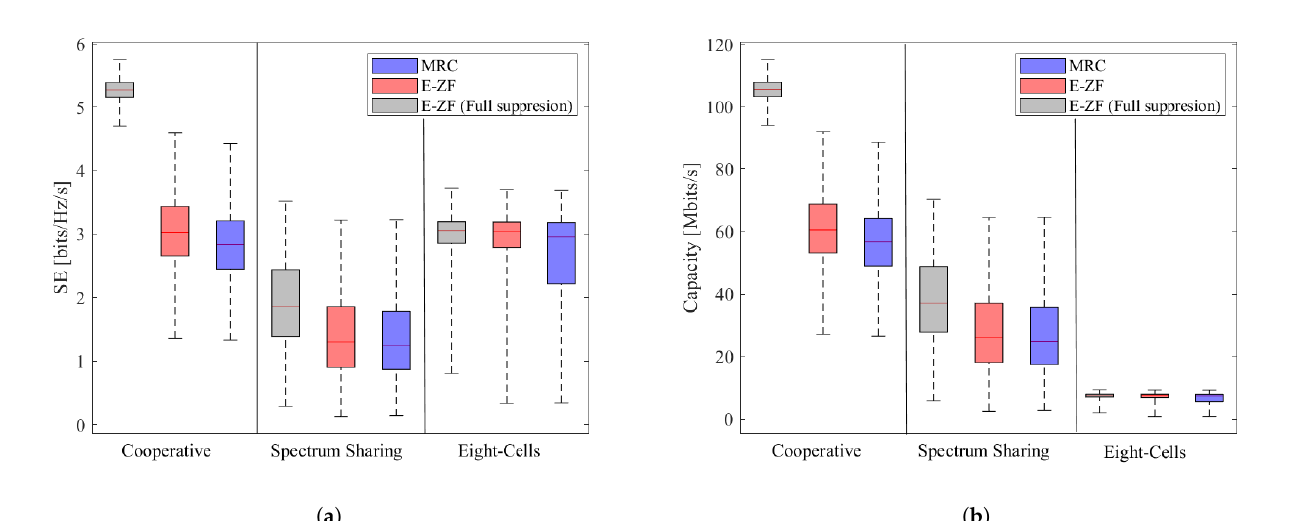
Figure 7. Users spectral efficiency and capacity distribution for E-ZF and MRC combining vectors. For the three system configurations: Cooperative, Spectrum Sharing and Eight-Cell, scenarios. When four interferer users are suppressed. ( a ) User spectral efficiency distribution per system. ( b ) User capacity distribution per system.